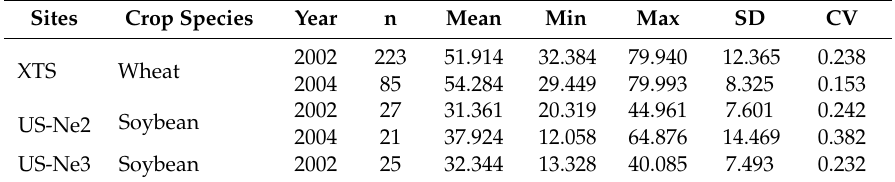
Table 2. Summary statistics of the measured wheat and soybean LCC ( µ g cm − 2